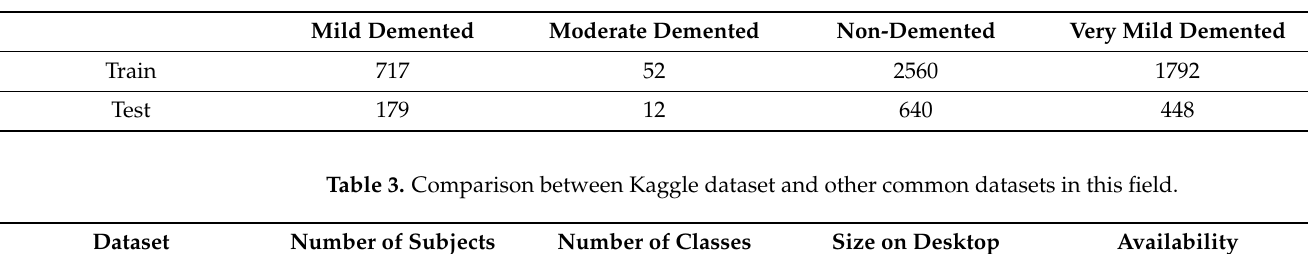
Table 2. Distribution of the records in the dataset used in this work.